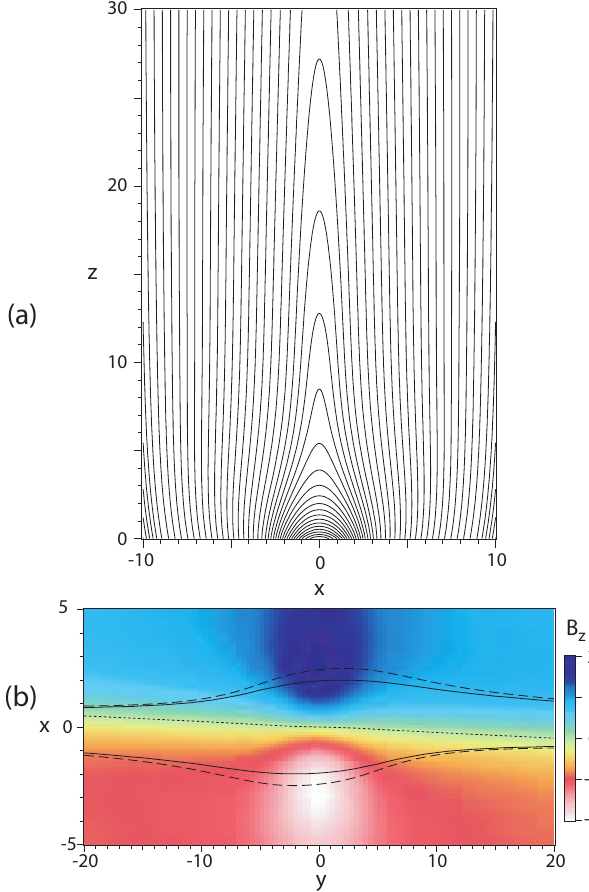
Fig. 1. (a) Initial magnetic field in the x,z plane and (b) the color-coded magnitude of the normal magnetic field B z at the bottom boundary z = 0 for a force-free initial state after relaxation. The dotted line indicates B z = 0 . The dashed and solid lines show the boundaries of field lines that close within the box before and after the foot point motion, respectively. Note that the full integration box size is given by | x | ≤ 10 , | y | ≤ 40 , and 0 ≤ z ≤ 60 .